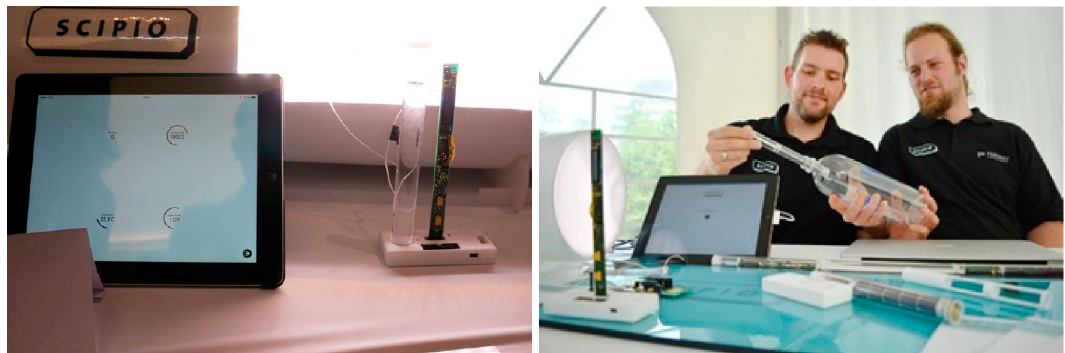
Figure 3. Measuremnt data within the tablet app and Communication of the Scipio device with the app running on the